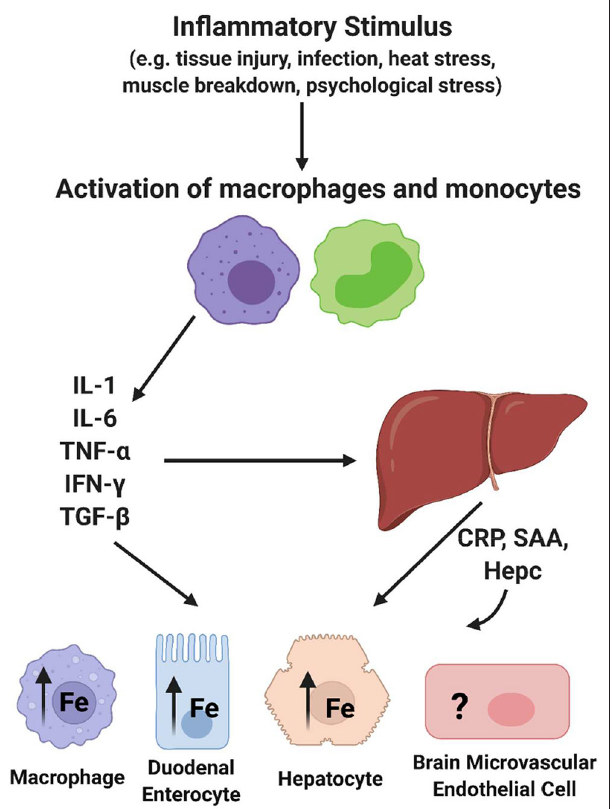
FIGURE 2 | Acute phase response effect on cellular iron trafficking. Essentially all of the cytokines released upon activation of macrophages and monocytes trigger changes in most if not all tissues with impact on their iron trafficking. In addition, several of the acute phase proteins released from hepatocytes (APP) have a sustaining effect on these processes. Hepcidin (Hepc) has the specific role of modulating the steady-state level of the sole iron efflux